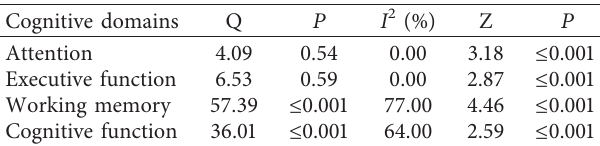
Table 2: Heterogeneity